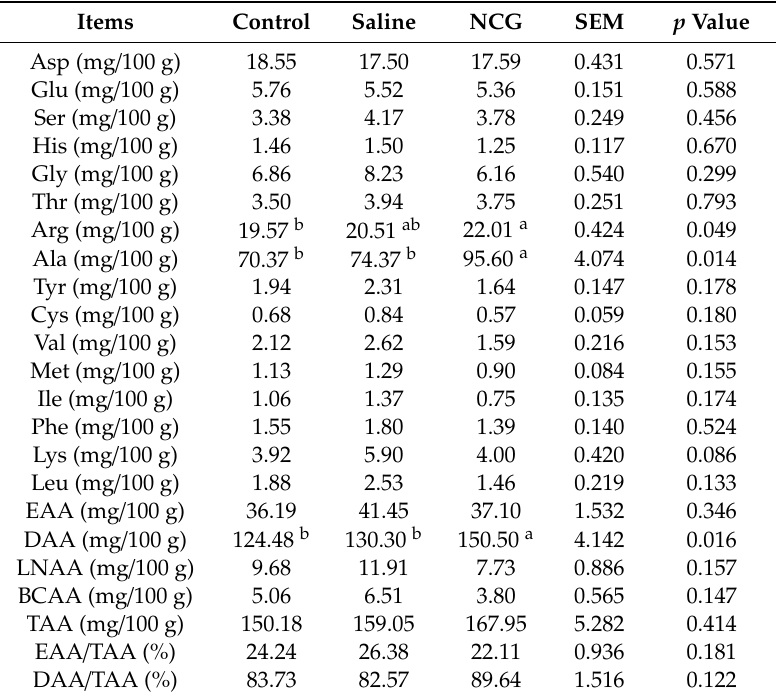
Table 8. Free amino acids of pectoral muscle in